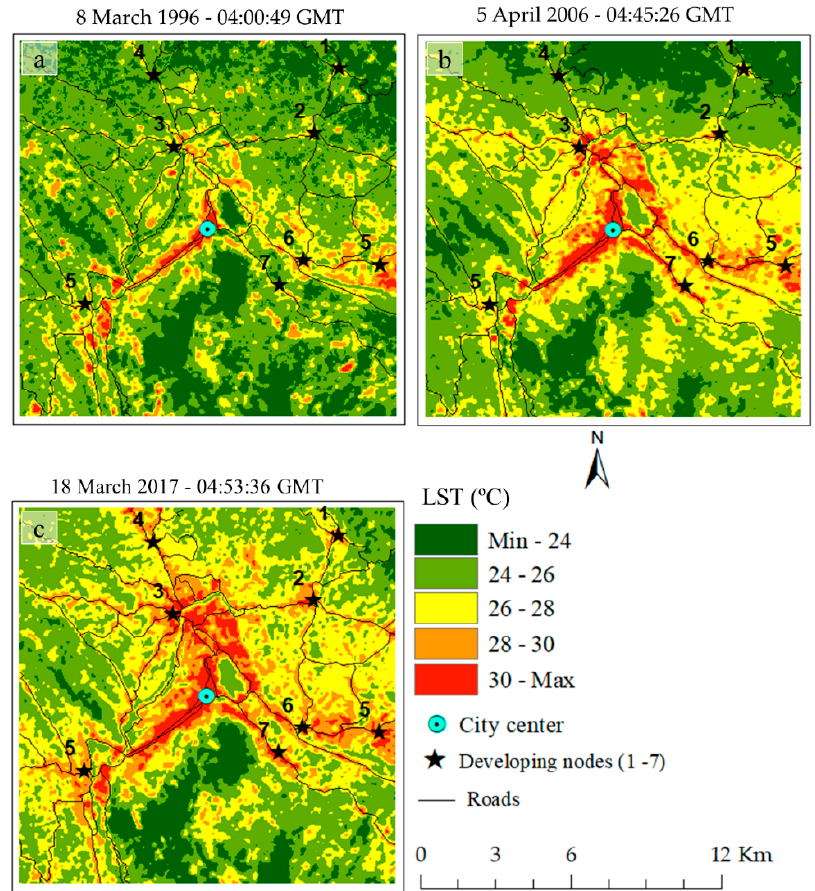
Figure 3. Land-surface temperature (LST) in ( a ) 1996, ( b ) 2006, and ( c ) 2017. Note: Developing nodes 1–7 are, respectively, Wattegama, Madawala, Katugastoata, Abathenna, Peradeniya, Thennekumbura, and Ampitiya.